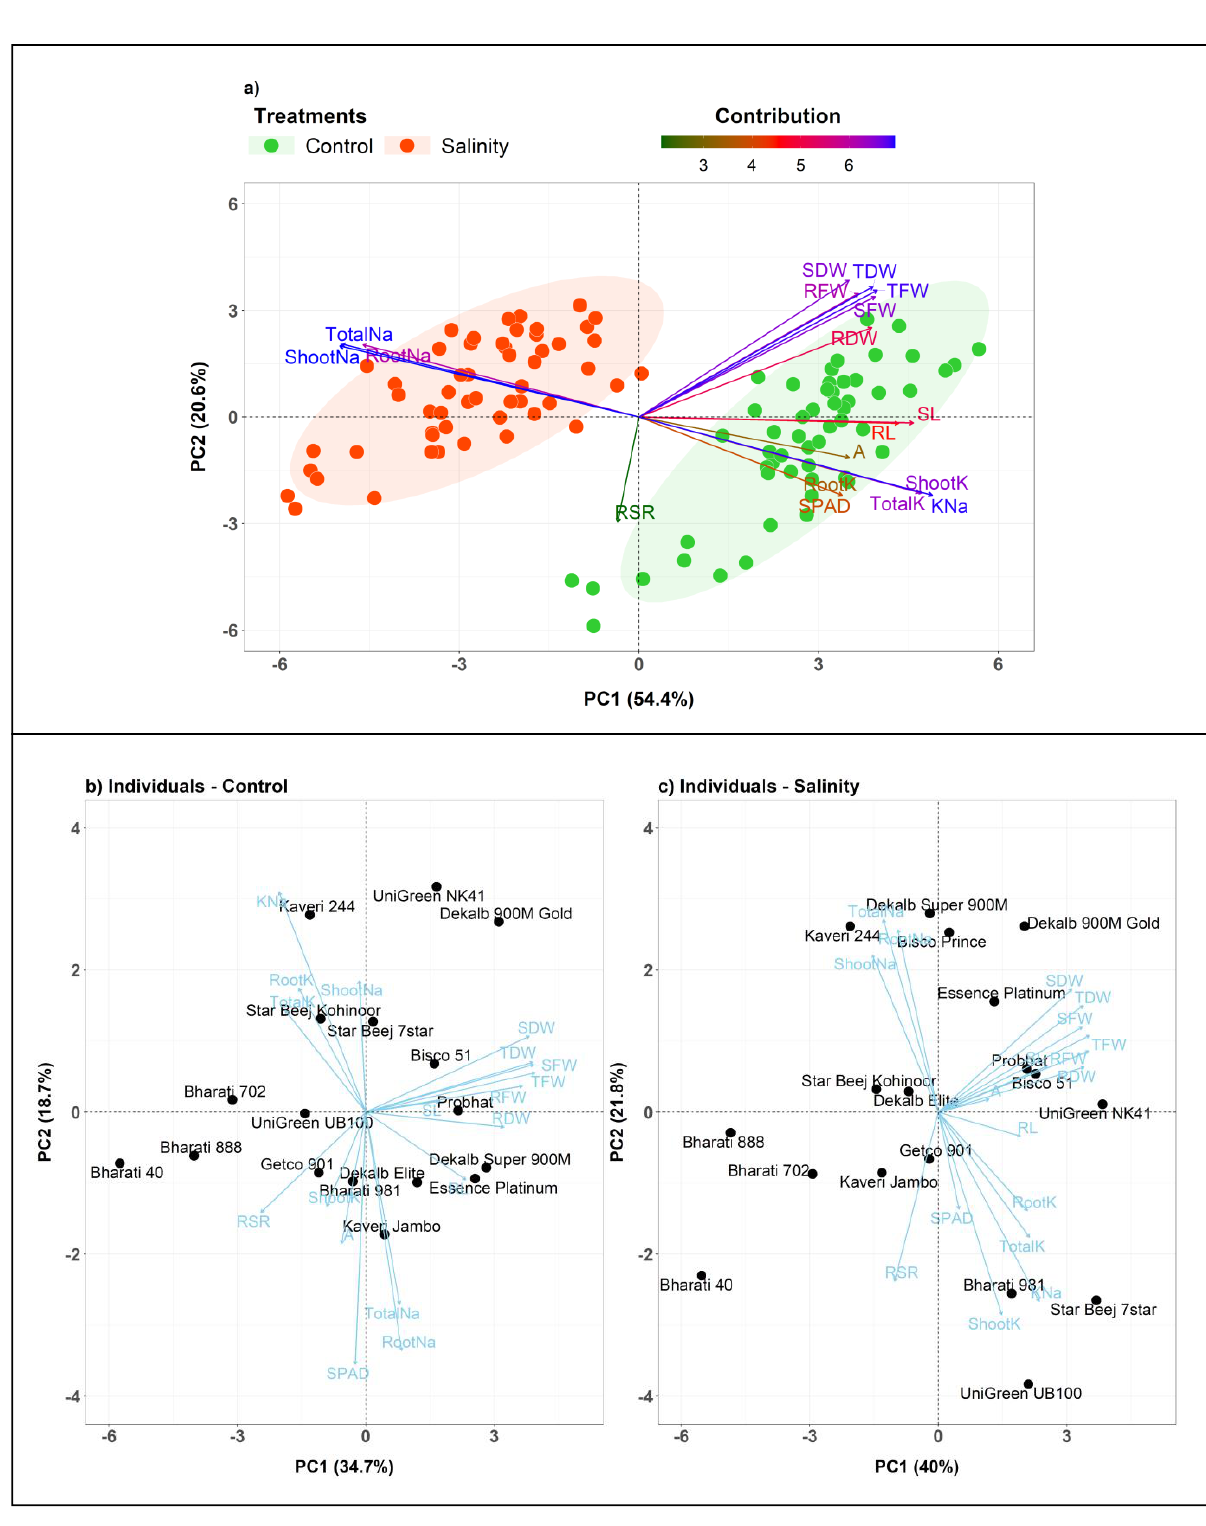
Figure 5. ( a ) Principal Component Analysis (PCA) − biplot of 18 maize cultivars based on the variance in 18 morpho − physiological and biochemical traits grown under control and salt conditions. The first two components explained 54.4% and 20.6% of the variances, respectively. Arrows indicate the strength of the trait influence on the first two PCs. The different color intensities and lengths of the arrows denote the contribution of the traits to the first two components in the PCA. The darker blue and longer arrows indicate a higher contribution, while the darker green and shorter arrows indicate the lower contribution of the variables. PCA − biplot of individual 18 maize genotypes with variables under ( b )